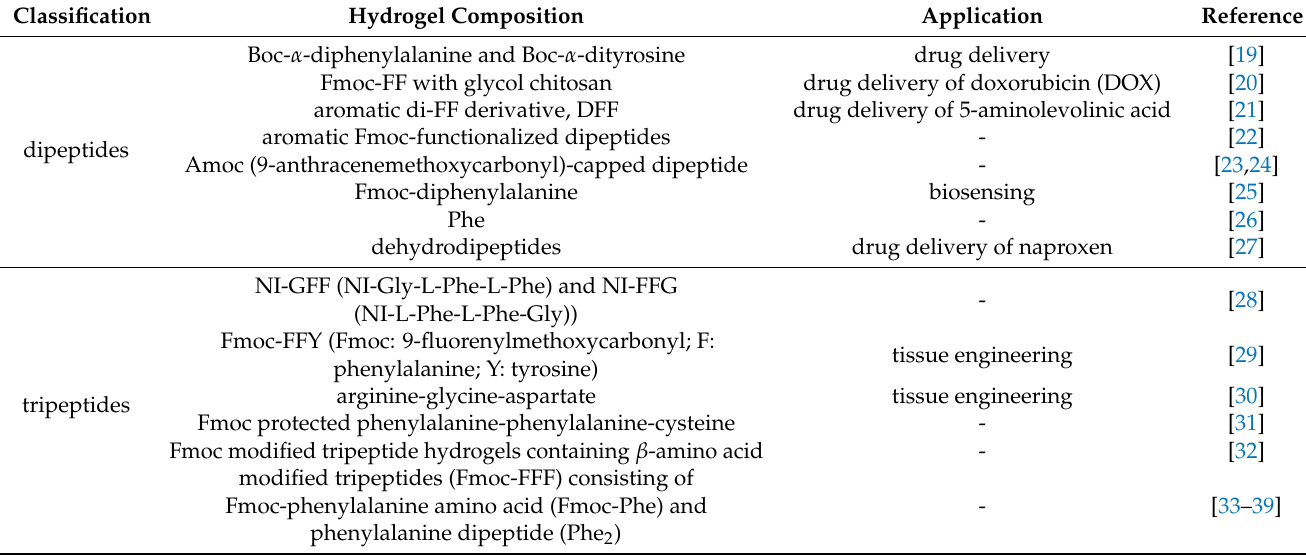
Table 2. Recent representative examples of biomedical applications of short peptide-based